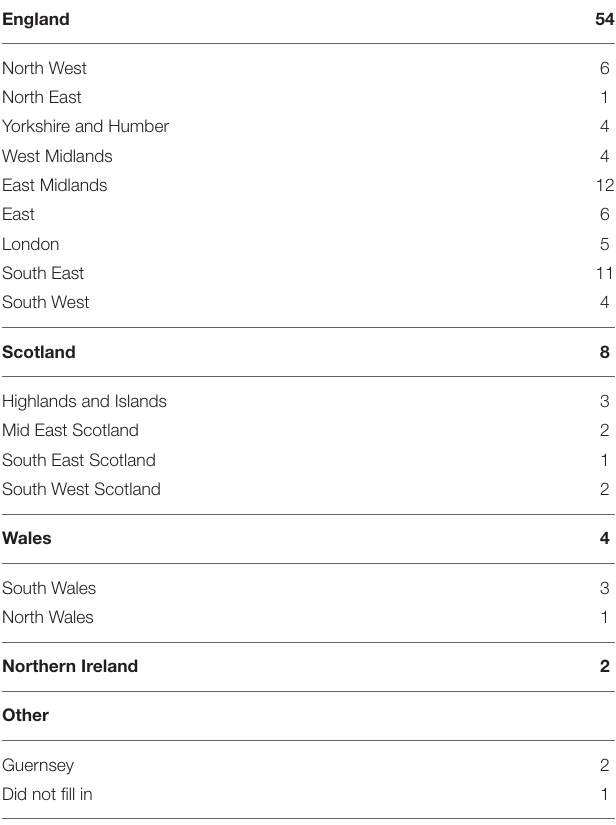
TABLE 2 | Geographical distribution of participants considering freebirth.